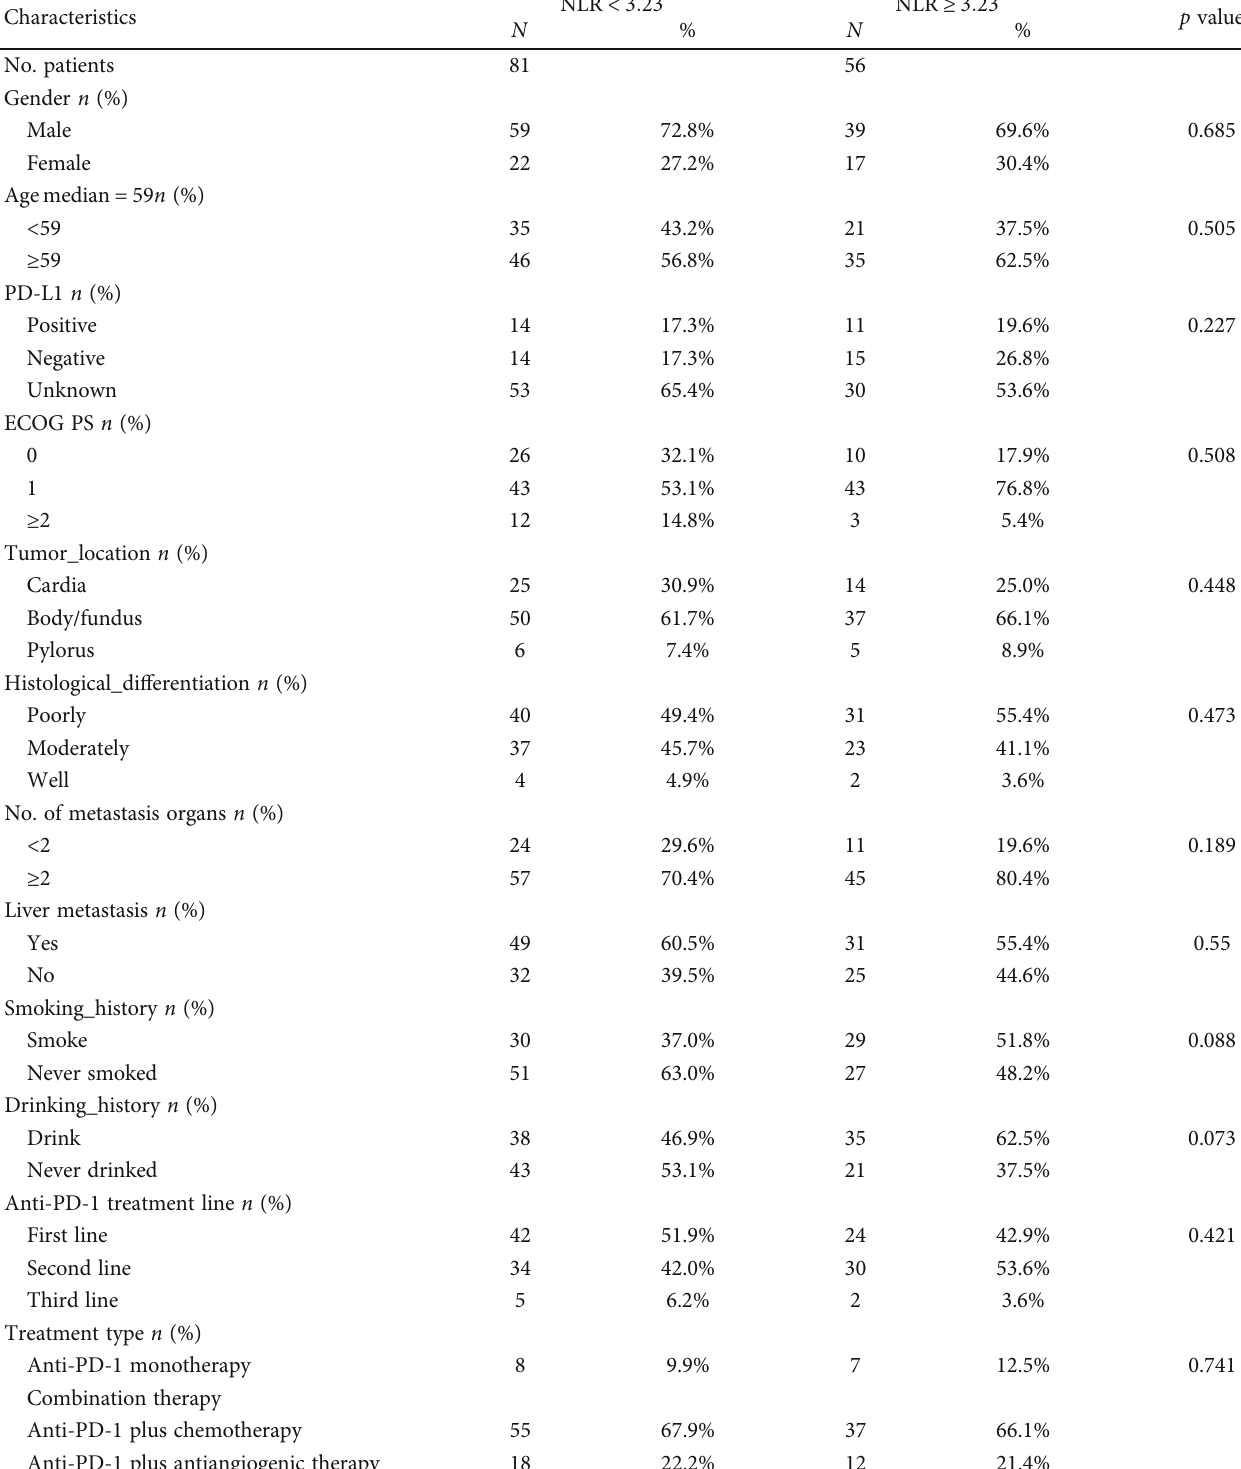
Table 1: The characteristics of the analyzed patients in di ff erent